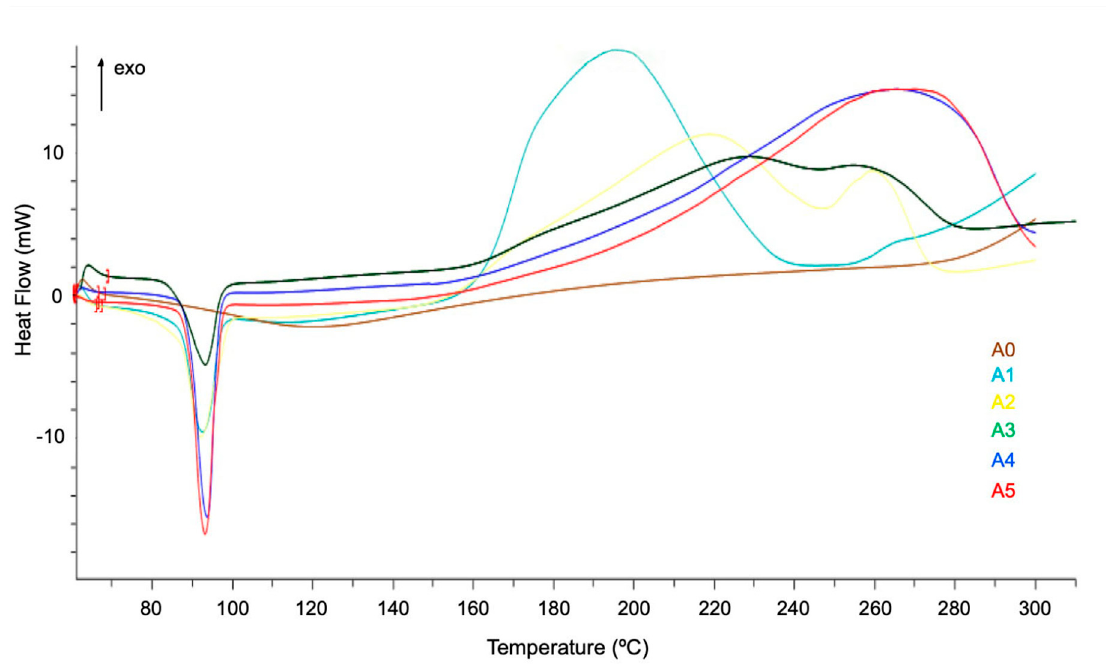
Figure 1. DSC thermograms of insulin-loaded PEG / mucin matrixes in superposition. Batch description: A0 = mucin / PEG / insulin (1:1:0), A1 = mucin / PEG / insulin (1:1:15), A2 = mucin / PEG / insulin